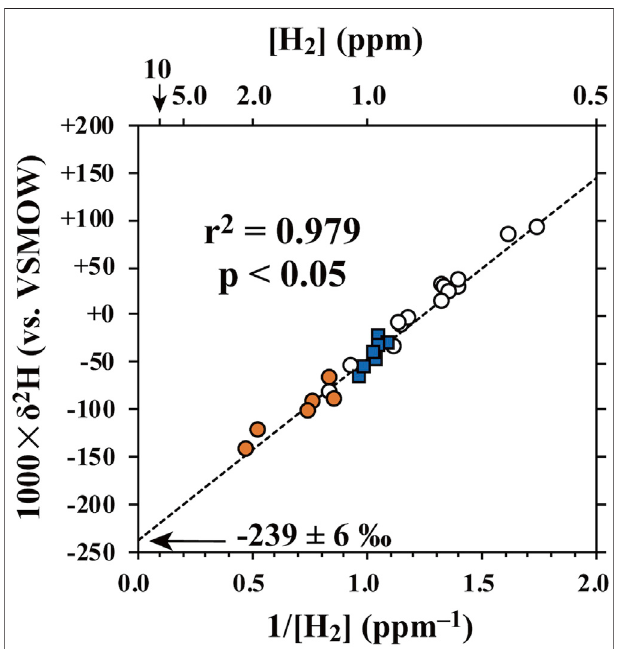
FIGURE 6 | Relationship between δ 2 H of H 2 and the reciprocal of H 2 concentration (1/[H 2 ]) in the plume/atmospheric samples collected automatically using SelPS (orange circles: plume samples derived from the main vent; blue squares: those derived from the southern fumaroles), along with those collected manually into pre-evacuated fl asks (white circles). The dotted line represents the regression line calculated for all the samples according to Cantrell,